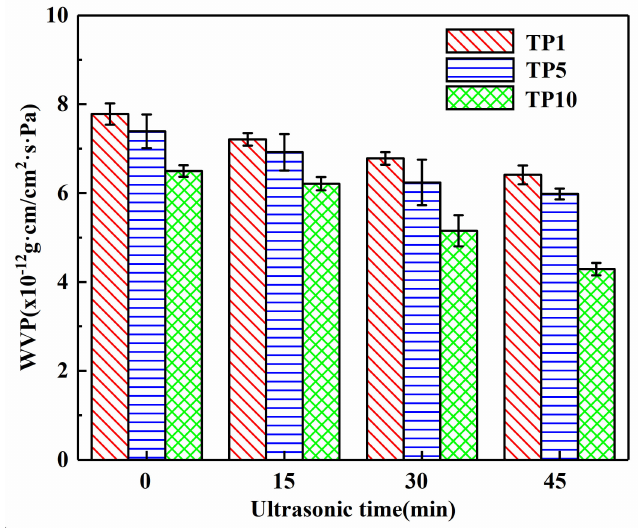
Figure 8. Water-vapor permeability on different mass ratios of PVA-HC/TP with different ultrasonic durations.